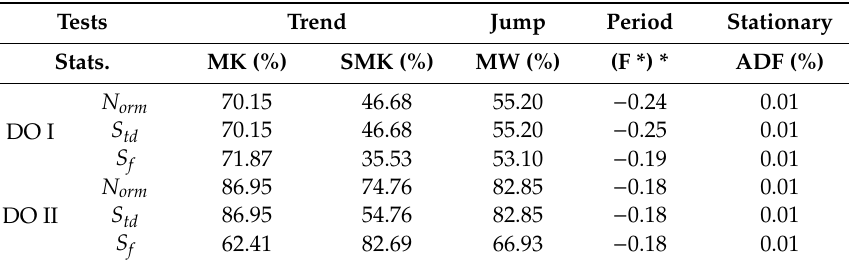
Table 3. Test results of subtracted data.